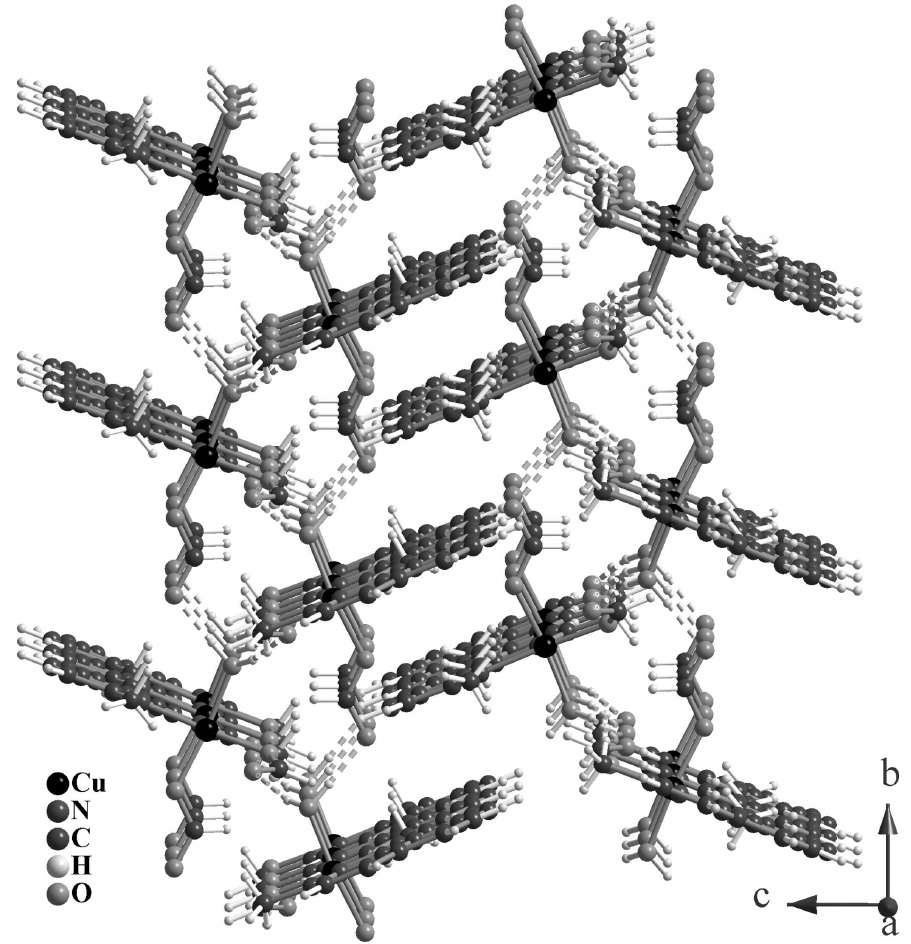
Figure 2 A perspective view of the crystal structure of (I), with hydrogen bonds shown as dashed lines. aqua(2,9-dimethyl-1,10-phenanthroline- κ 2 N , N ′ )bis(formato- κ